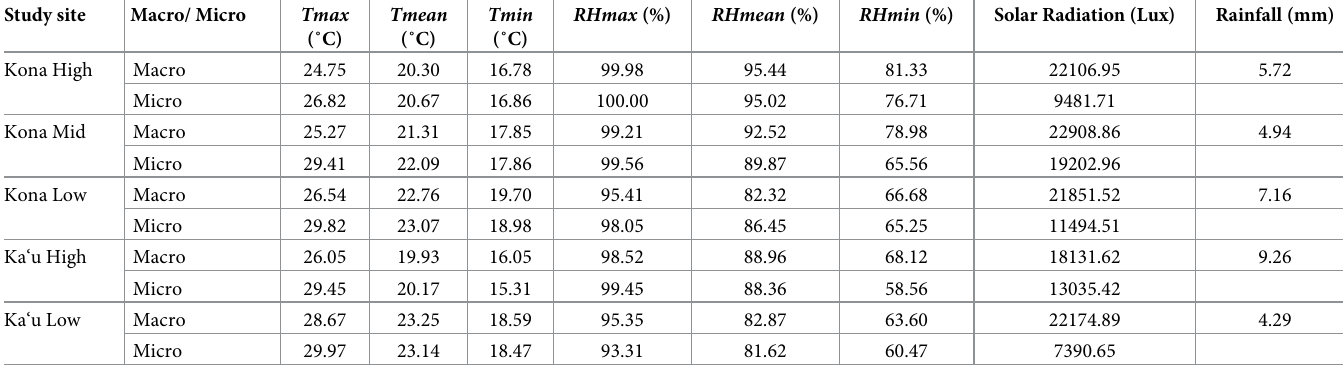
Table 2. Mean daily values (maximum, mean, and minimum) for macro- and micro-scale weather variables by site from September–November 2017. Micro-scale data represents the mean from 10 sample branches at each site. Study site Macro/